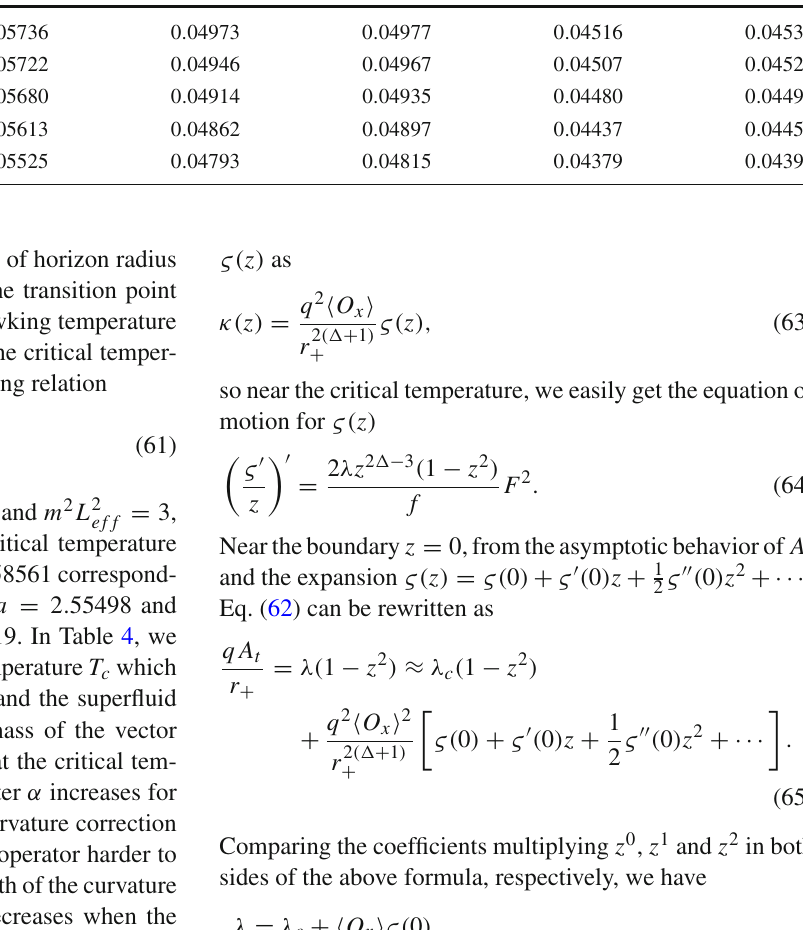
Table 4 The critical temperature T c / q μ of the holographic p-wave superfluid model obtained by the analytical S–L method (left column) and by numerical calculation (right column), with different values of − 0 .